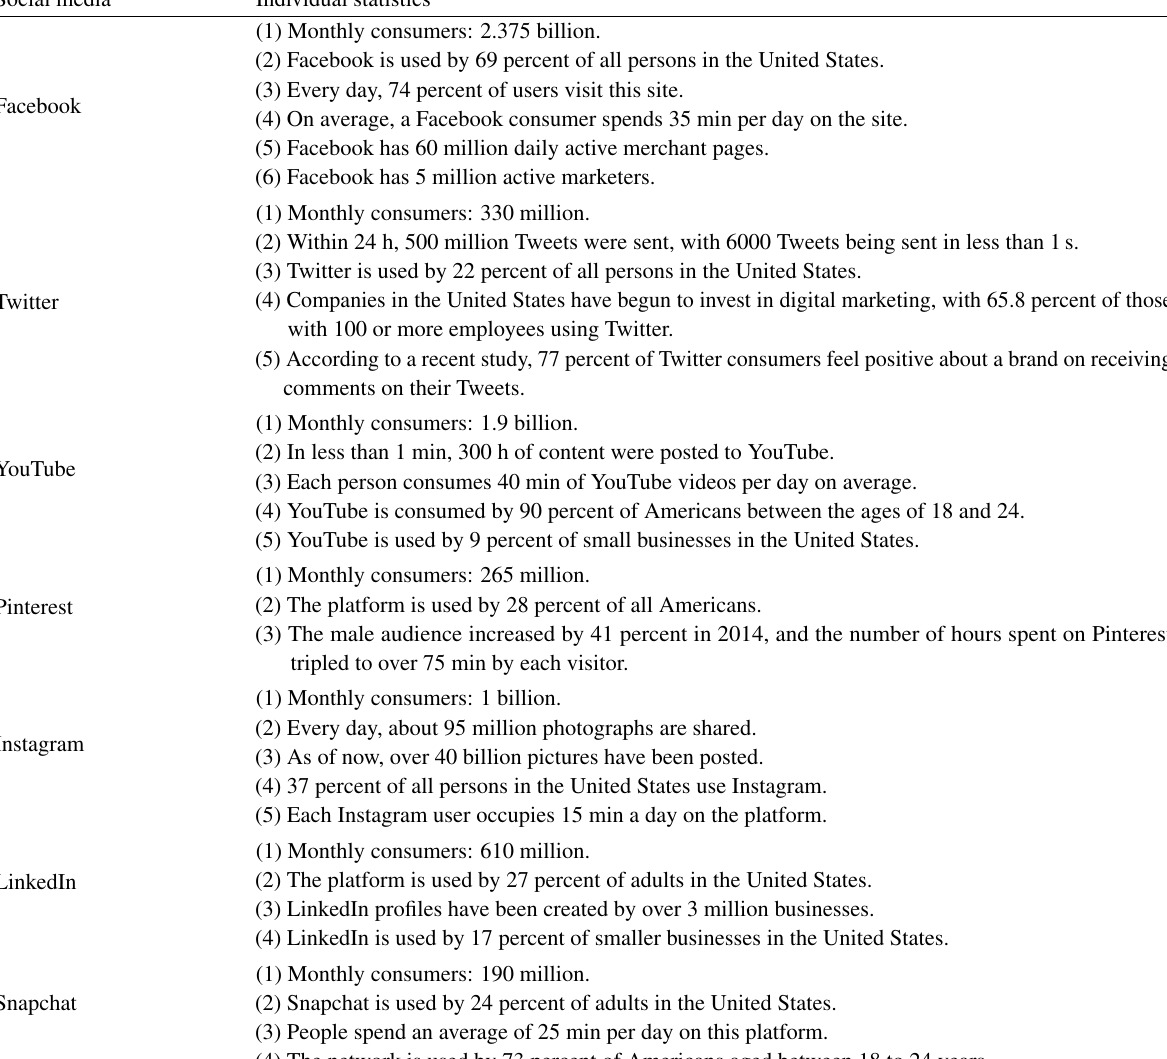
Table 4 Statistics of seven well known social media